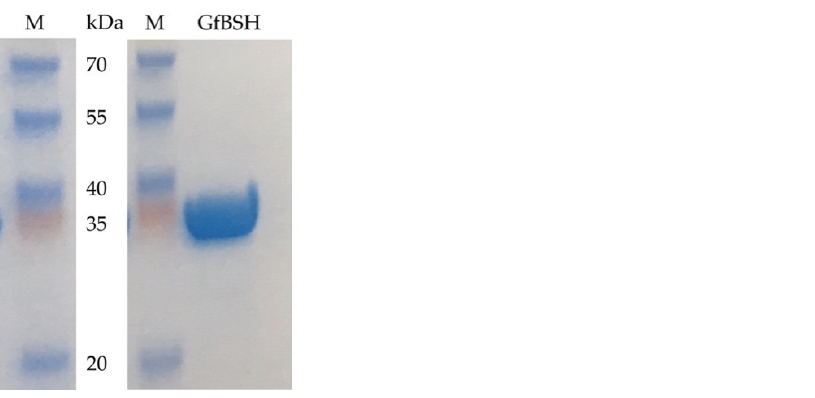
Figure 3. Sodium dodecyl sulfate polyacrylamide gel electrophoresis (SDS-PAGE) analysis of purified LcBSH and GfBSH. The purified proteins were loaded onto 12% SDS-PAGE gels. The single protein bands of purified His 6 -LcBSH and His 6 -GfBSH proteins were observed to be around 35 kDa. Lane M, molecular size-marker (3-color prestained XL-Ladder, APRO Science, Tokushima, Japan).